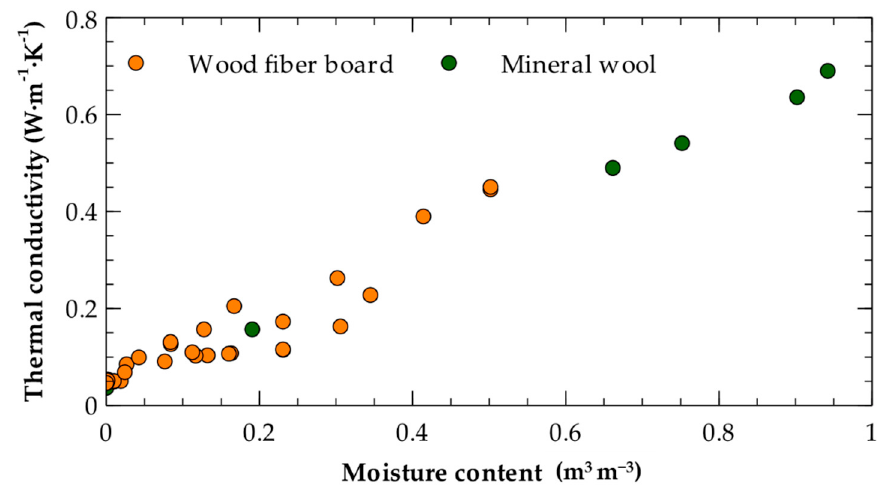
Figure 6. Heat transport properties of thermal insulations.